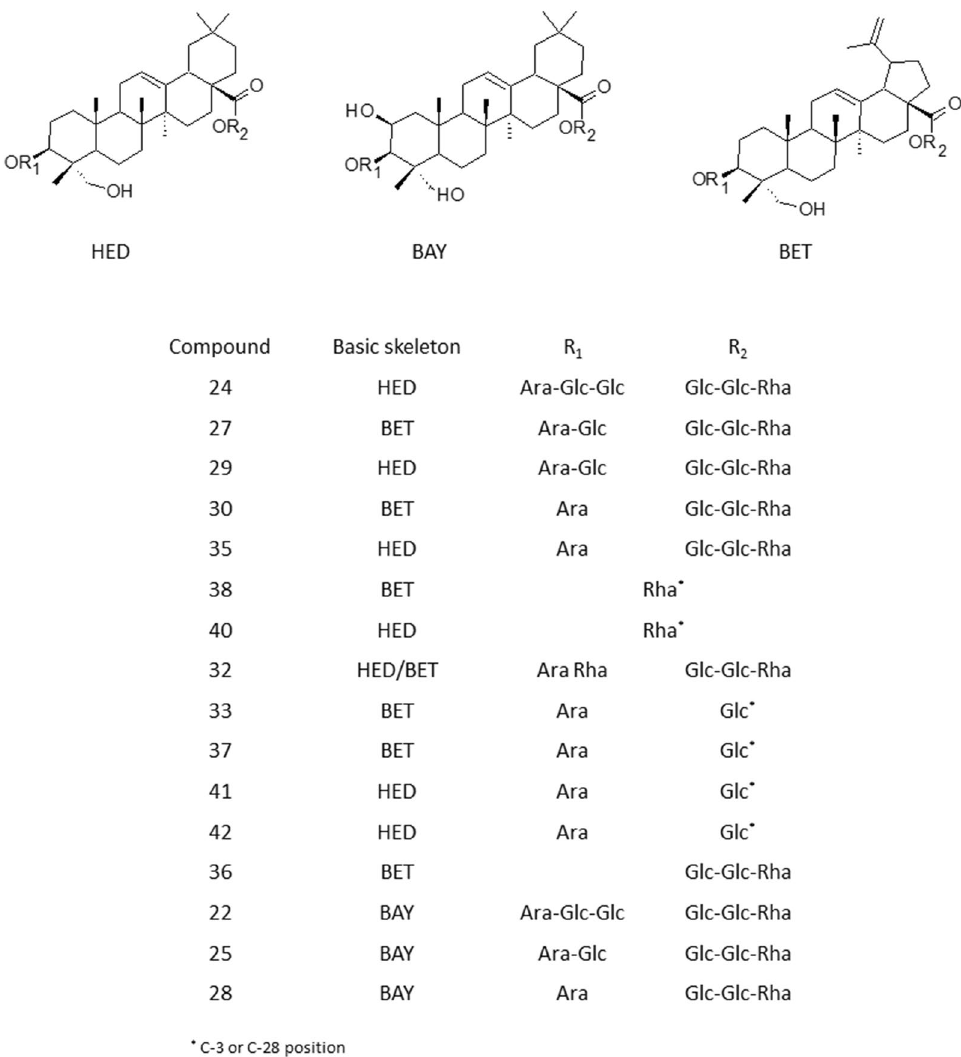
Figure 4. Types of triterpenoid saponins identified in P. patens